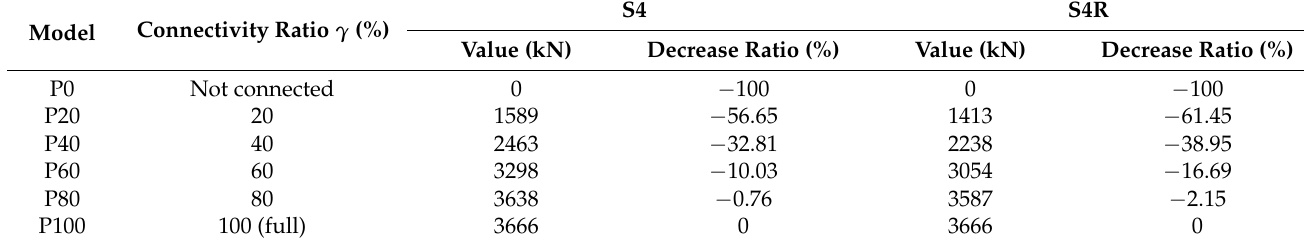
Table 6. Results of shear strength for S4 and S4R models.